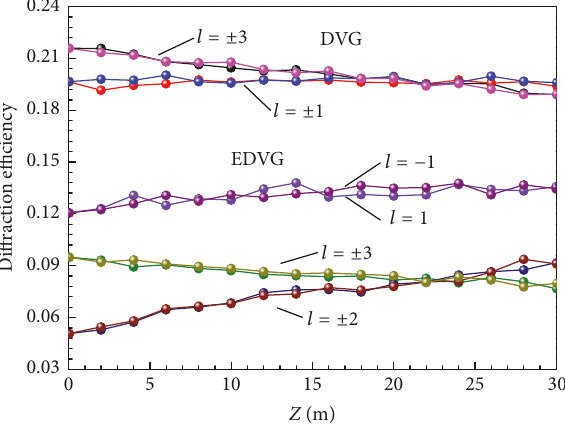
Figure 6: The diffraction efficiency of every diffraction